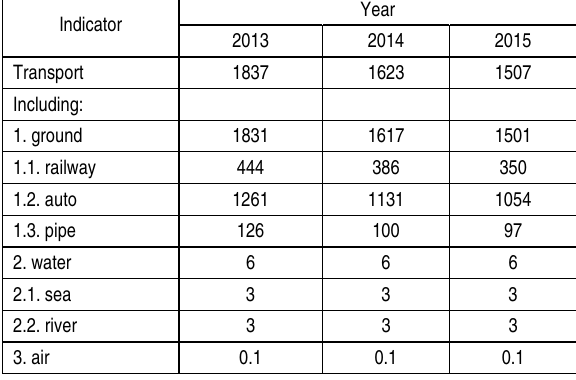
Table 5. Transportation of cargoes according to